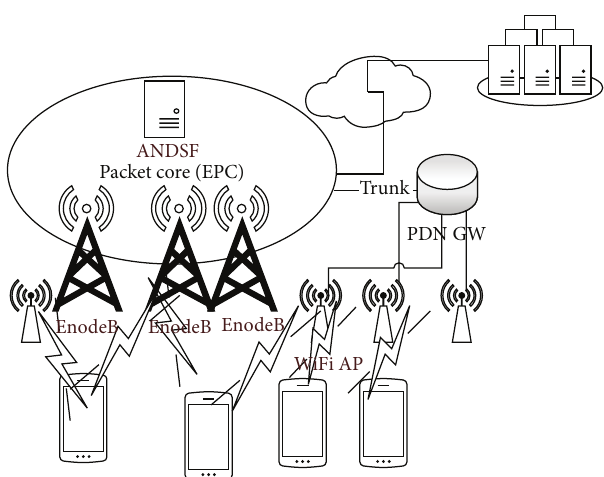
Figure 1: Heterogeneous network scenario with LTE cellular and WiFi